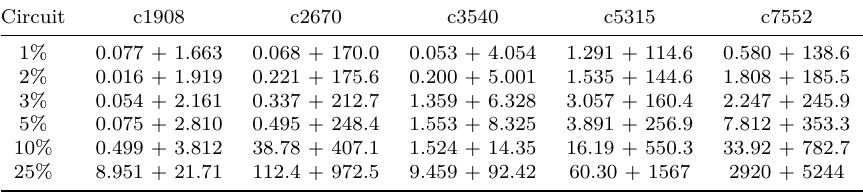
Table 4: Execution Time of the SMT Attack in the Eager Mode (Attack Mode 2) on ISCAS-85 Benchmarks with Different Overhead when Obfuscated using DLL[XS17]+ RLL[RKM10] (50%-50%) Obfuscation